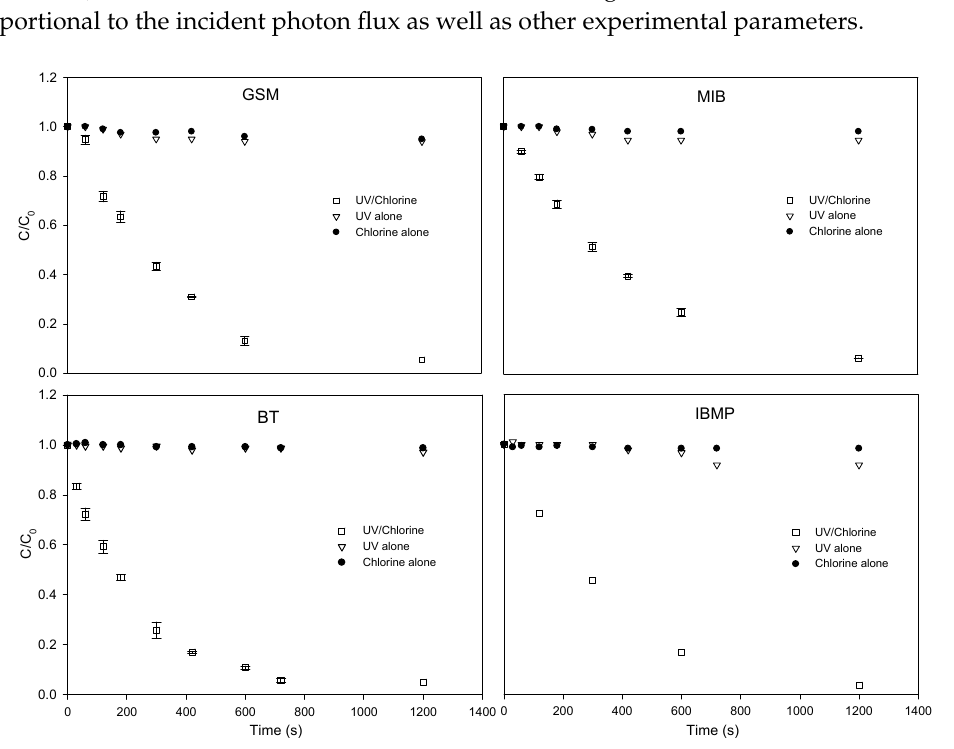
Figure 1. Time-dependent degradation of GSM, MIB, BT, and IBMP in pure water through oxidation by UV/chlorine, UV alone, and chlorination alone. Conditions: pH = 6; chlorine concentration = 50 µ M; GSM and MIB concentration = 400 nM; BT and IBMP concentration = 1 µ M; nitrobenzene (NB) concentration = T&O compound concentration; Incident photon flux = 0.69 µ Einstein L − 1 s − 1